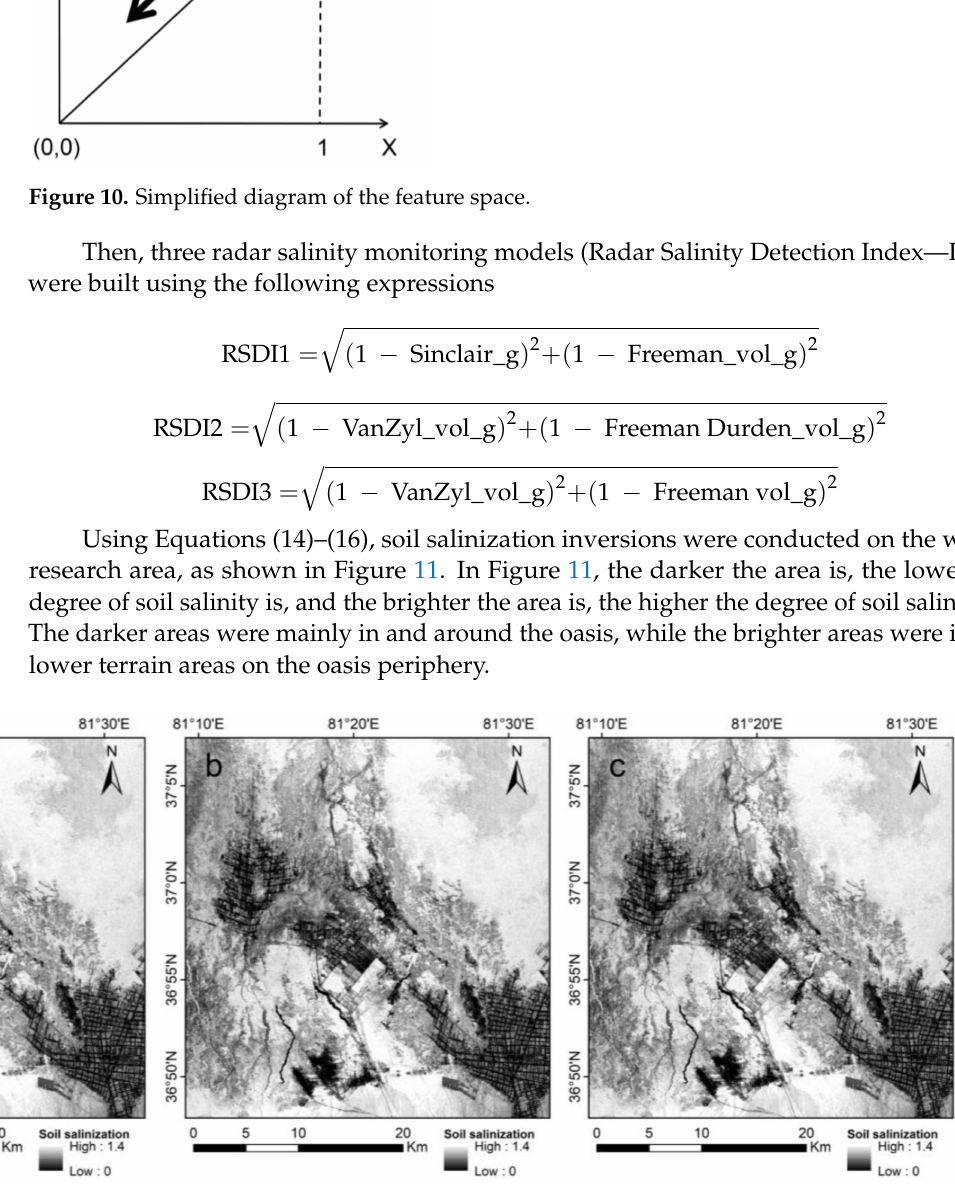
Figure 11. Spatial distribution patterns of different levels of soil salinization: ( a ) RSDI1; ( b ) RSDI2; ( c )